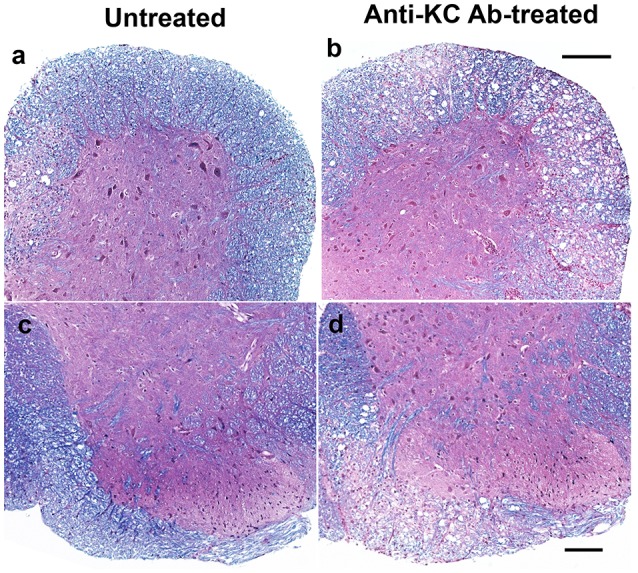
Comparison of histopathology in the spinal cords of anti-KC antibody-treated SJL mice and control SJL mice at 35 dpi. Histopathology of the spinal cords of virus-infected mice was examined using LFB and H&E staining. LFB stain showing myelin in blue in the white matter of spinal cords of anti-KC antibody-treated SJL mice (b,d) and SJL mice (a,c); H&E stained nuclei in dark blue indicating lymphocyte infiltration in the spinal cords of anti-KC antibody-treated SJL mice (b,d) and SJL mice (a,c); Scale bars a, b = 200 μm; c, d = 100 μm.